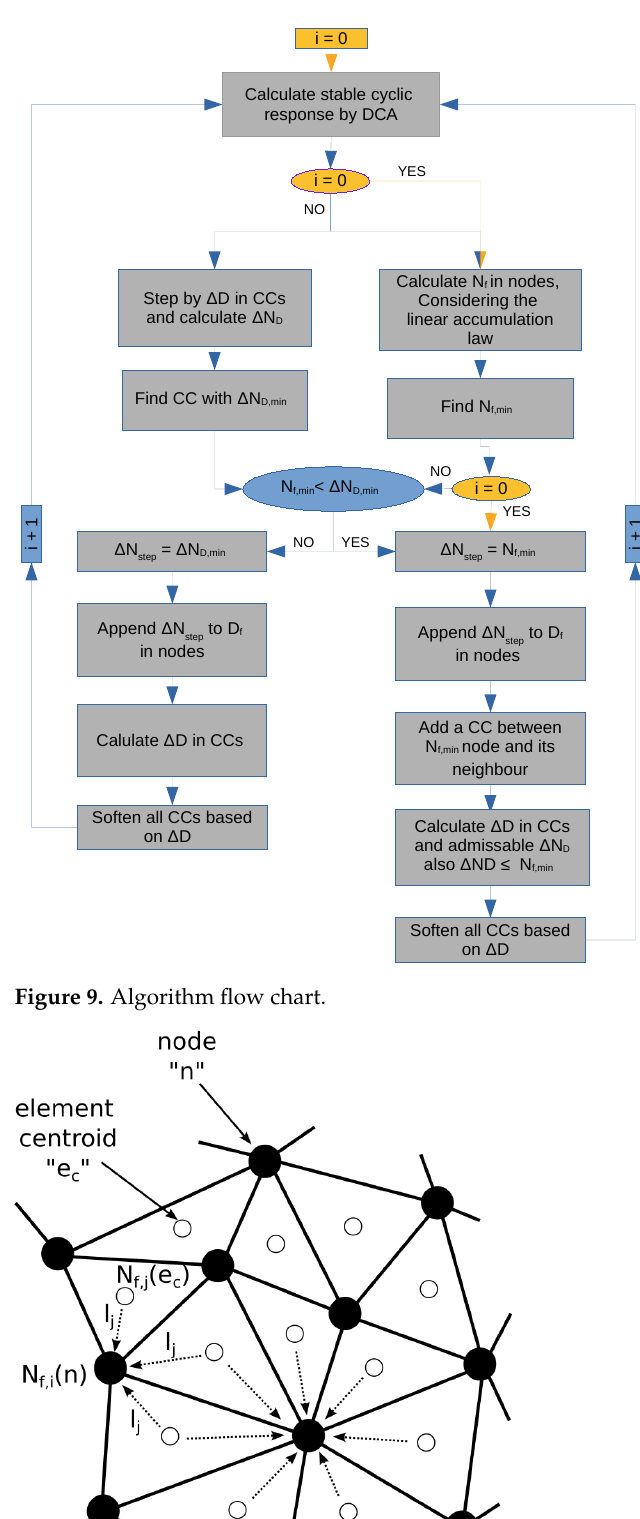
Figure 10. Node average